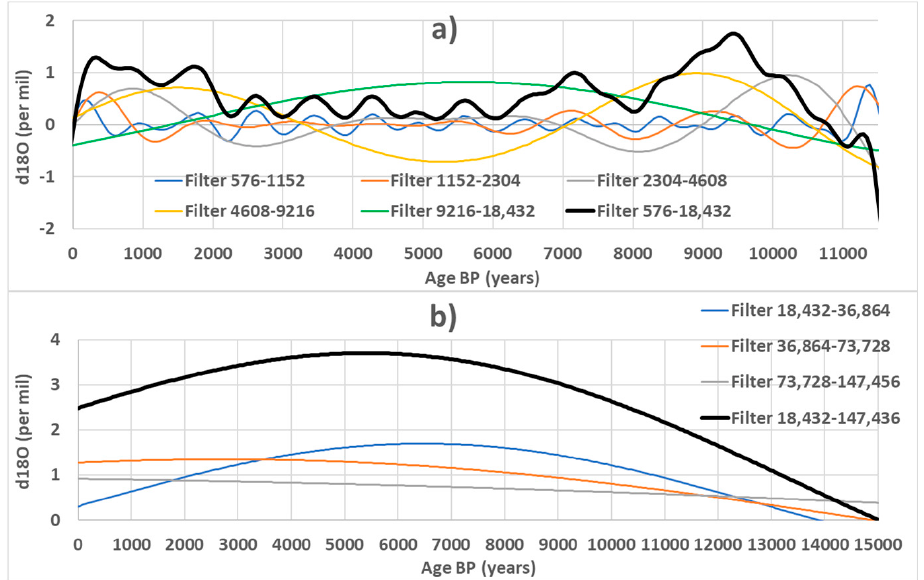
Figure 7. Long-period temperature signal obtained by filtering the proxy δ 18 O in GRIP ice core; ( a ) filters characteristic of the subharmonic modes n 4 = 3 × 2 2 , n 5 = 3 × 2 3 , n 6 = 3 × 2 4 , n 7 = 3 × 2 5 , and n 8 = 3 × 2 6 (mean periods = 768, 1536, 3072, 6144, and 12,288 yrs) and the sum (filter 576–18,432 yrs); ( b ) filters characteristic of the subharmonic modes n 9 = 3 × 2 7 , n 10 = 3 × 2 8 , and n 11 = 3 × 2 9 (mean periods=24,576, 49,152, and 98,304 yrs) and the sum (filter 18,432–147,436 yrs).